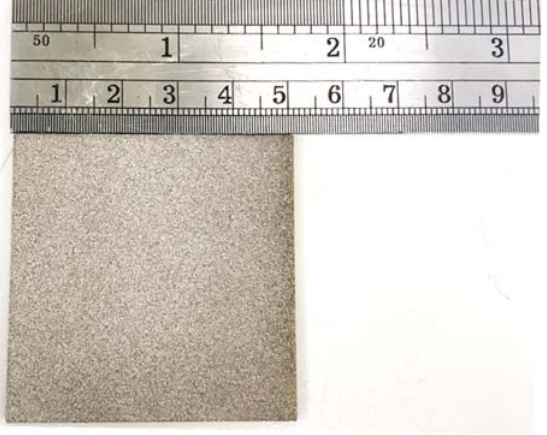
Figure 3. Macroscopic image of the Al 0.5 CoCrFeNi 2 Ti 0.5 ‐ sprayed coatings.